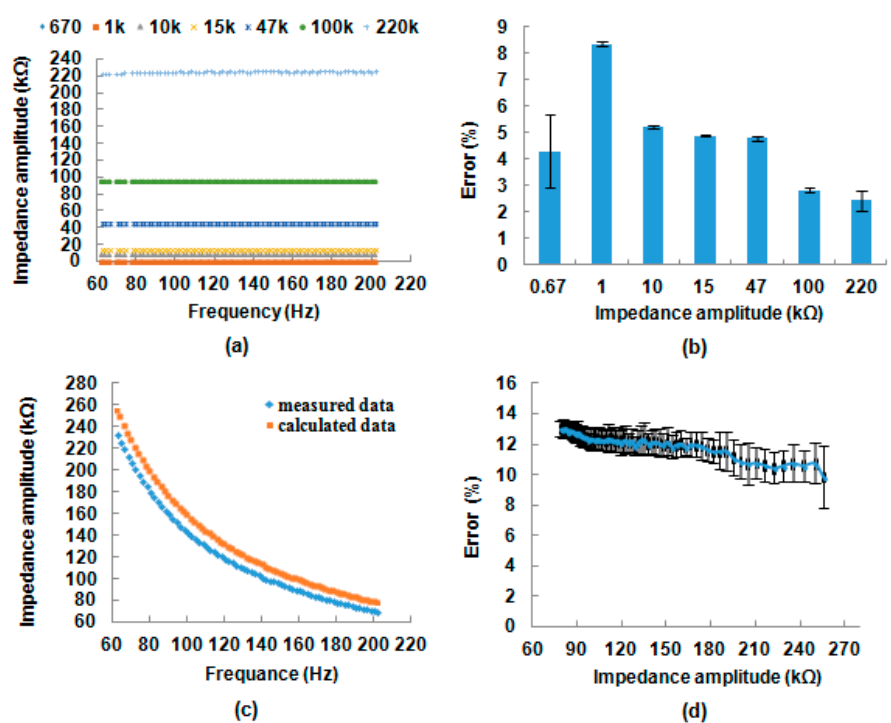
Figure 6. Evaluation of standard impedance elements in the portable impedance immunosensing system, ( a ) mean values; ( b ) error distribution of standard resistors; ( c ) mean values; and ( d ) error distribution of standard capacitors. The means and standard error bars were determined using three replicates.